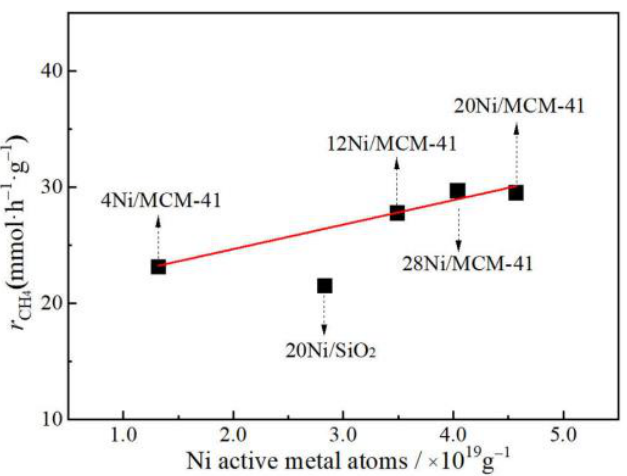
Figure 8. Relationship between the numbers of active Ni atom and initial CH 4 yield rate per unit mass of catalyst at 300 °C.